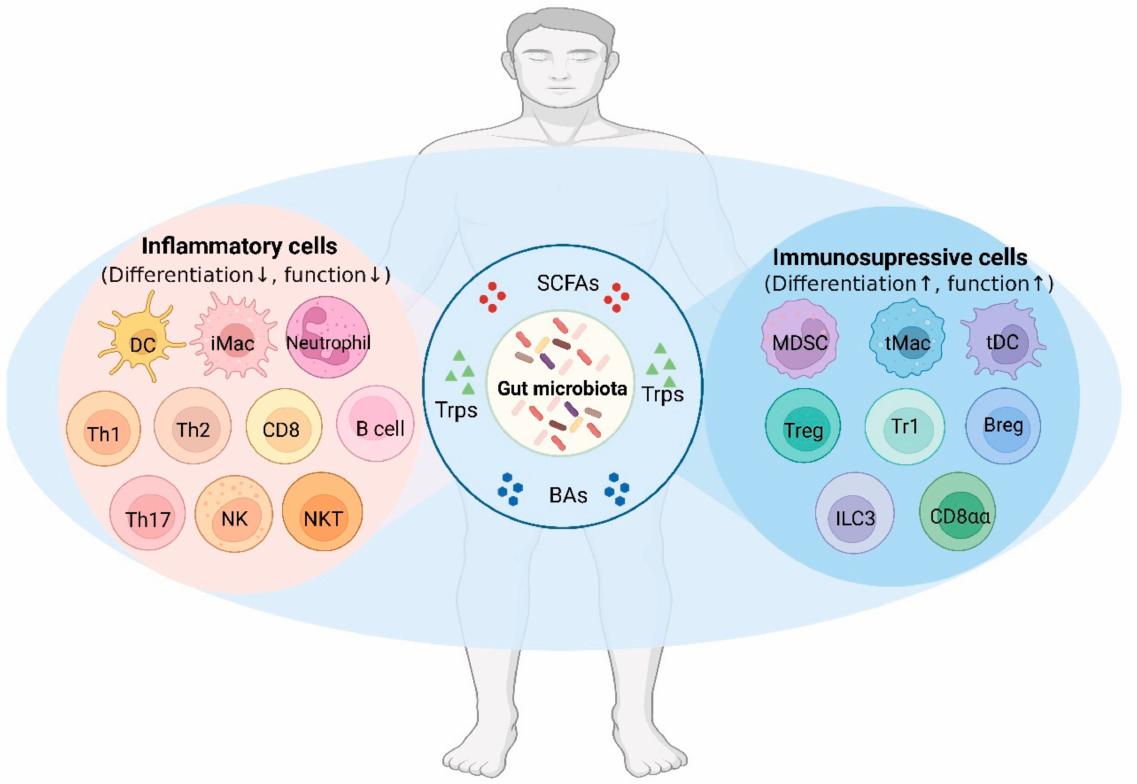
Figure 1. The gut microbiota maintains the homeostasis of the gut and systemic immune system through the metabolites. Metabolites from the gut microbiota such as short-chain fatty acids (SCFAs), tryptophan metabolites (Trps), and bile acid metabolites (BAs) promote the differentiation and function of immune-suppressive cells and inhibit the inflammatory cells. DC, dendritic cell; iMac, inflammatory macrophage; Th1, T helper 1; Th2, T helper 2; Th17, T helper 17; NK, natural killer cell; NKT, natural killer T cell; MDSC, myeloid-derived suppressor cell; tMac, tolerogenic macrophage; tDC, tolerogenic dendritic cell; Treg, regulatory T cells; Tr1, type 1 regulatory T cells; Breg, regulatory B cell; ILC3, innate lymphoid cell 3; CD8 αα , CD4 + CD8 αα + intestinal intraepithelial